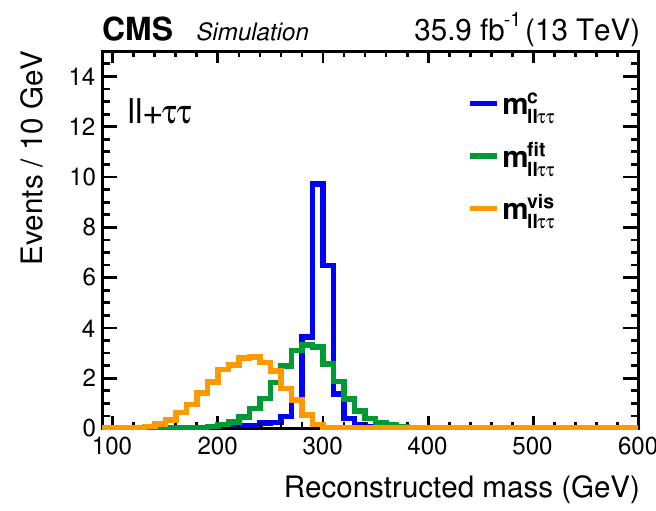
Figure 2 . The distribution of the A boson mass for the three studied mass reconstruction methods at 300 GeV: using only the visible decay products ( m vis green), and using the svfit algorithm with a mass constraint of 125 GeV for the Higgs boson ( m c blue). The eight (cid:12)nal states of the A boson decay are combined for visualization purposes.